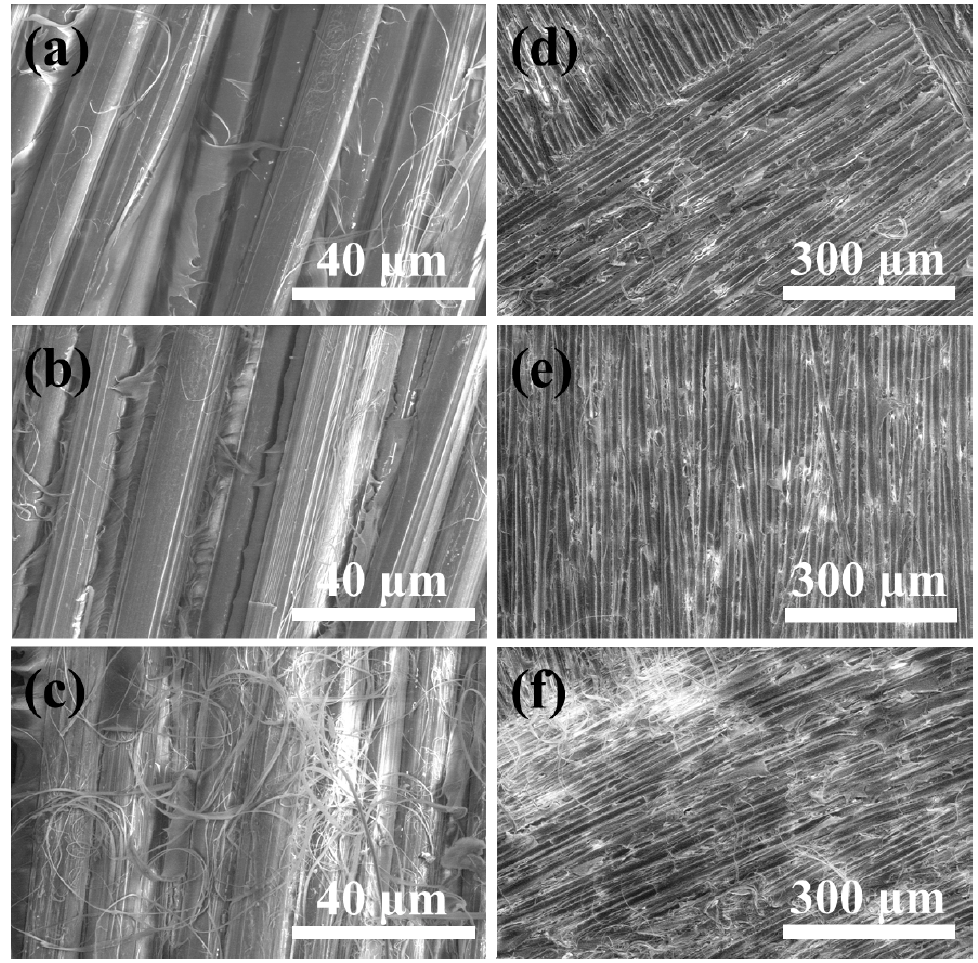
Figure 10. SEM images of PPTA fabric after peel test without plasma treatment ( a ); with only UHMWPE treated for 1 min ( b ); with only PPTA treated for 5 min ( c ) and SEM images of UHMWPE after peeling test without treatment ( d ); with only UHMWPE treated for 1 min ( e ); with only PPTA treated for 5 min ( f ).